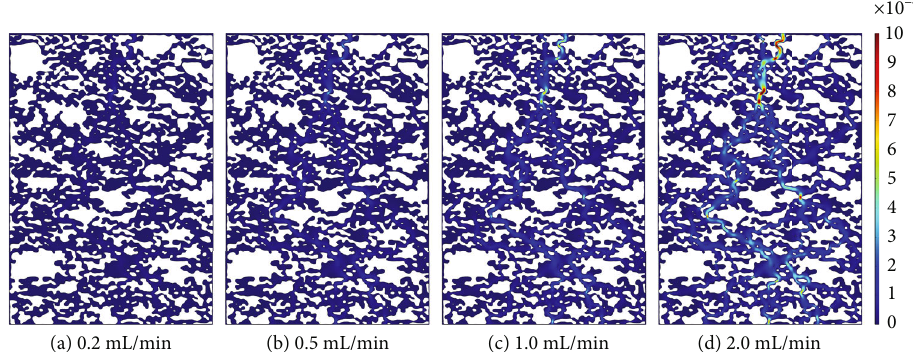
Figure 8: Steady-state fl ow fi eld under di ff erent injection intensities.